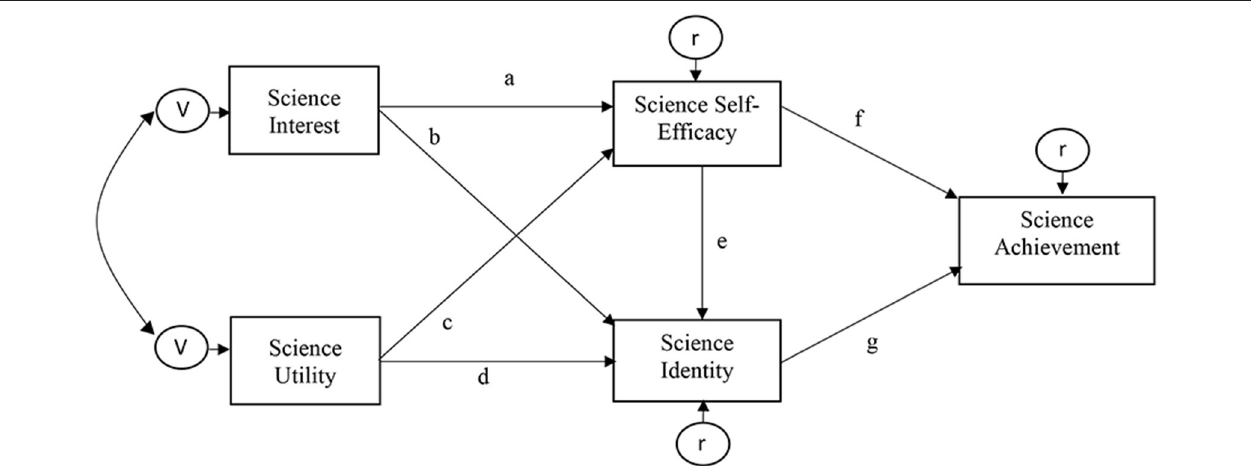
FIGURE 1 | Conceptual model of the associations between science-related variables and science achievement. The double-headed curved arrow implies the covariance between the variance terms of the exogenous variables, which are, in this case, science utility and science interest. The right-to-left arrows and associated V in circles pointing toward science interest and utility are variance terms. The remaining three variables are endogenous, i.e., science self-efficacy, science identity, and science achievement. The right-to-left arrows and associated e in circles pointing toward these three variables are the residuals/unexplained variance terms of the endogenous variables due to error and other unmodeled